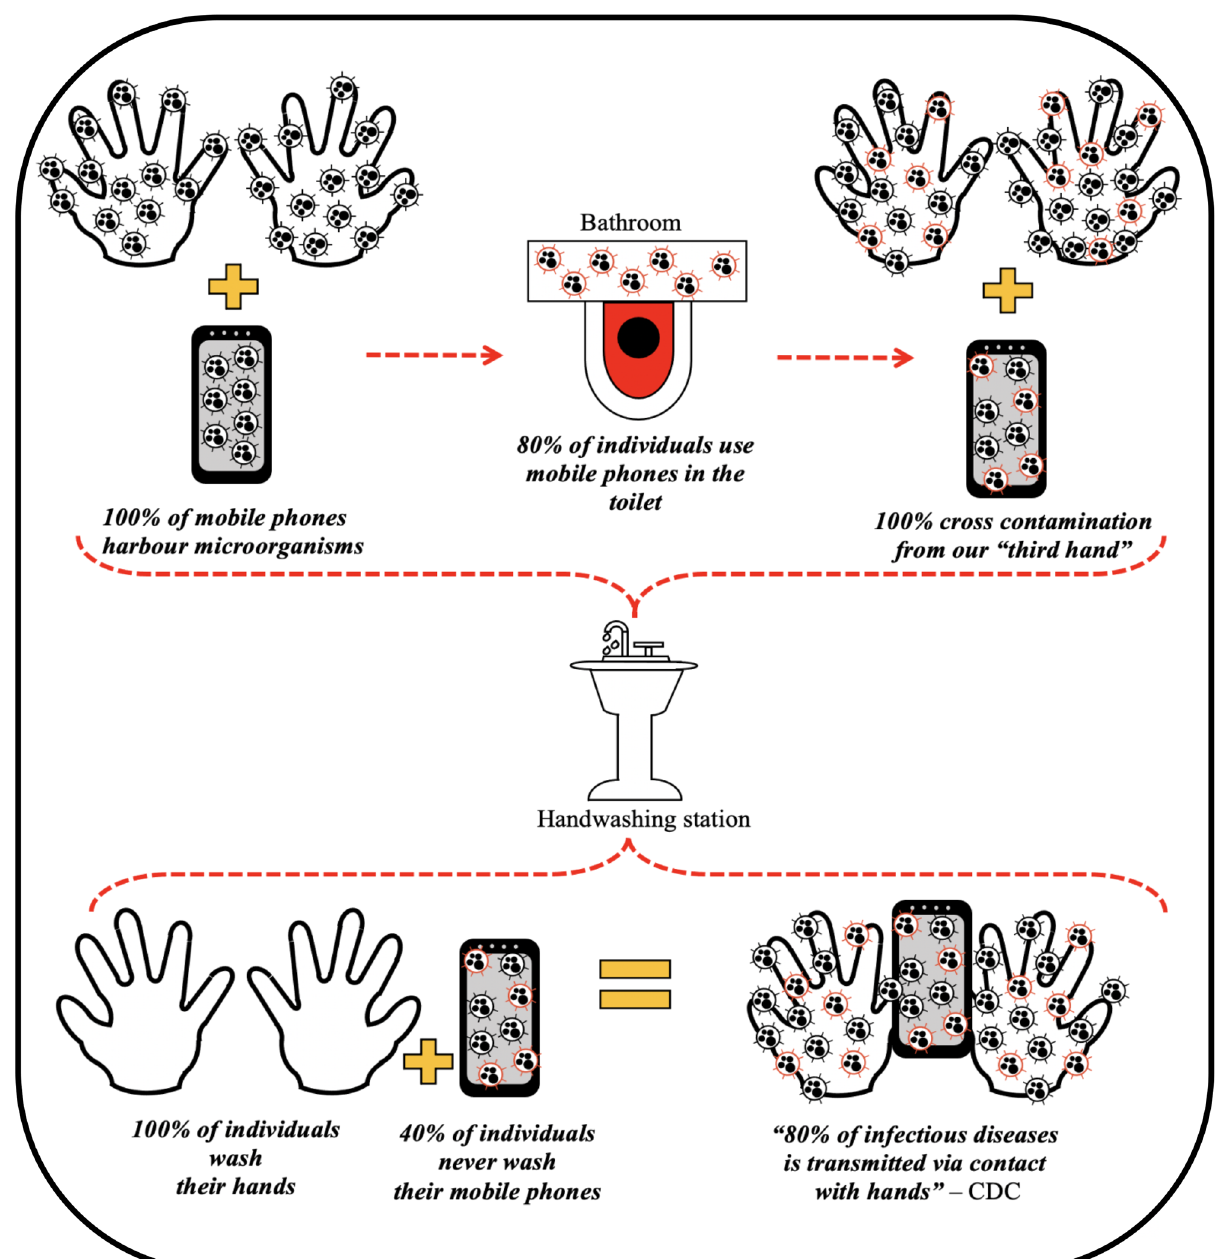
Figure 8. Infographic representation_Mobile phones serving as ‘Trojan Horse’ bypassing the current gold standard handwashing